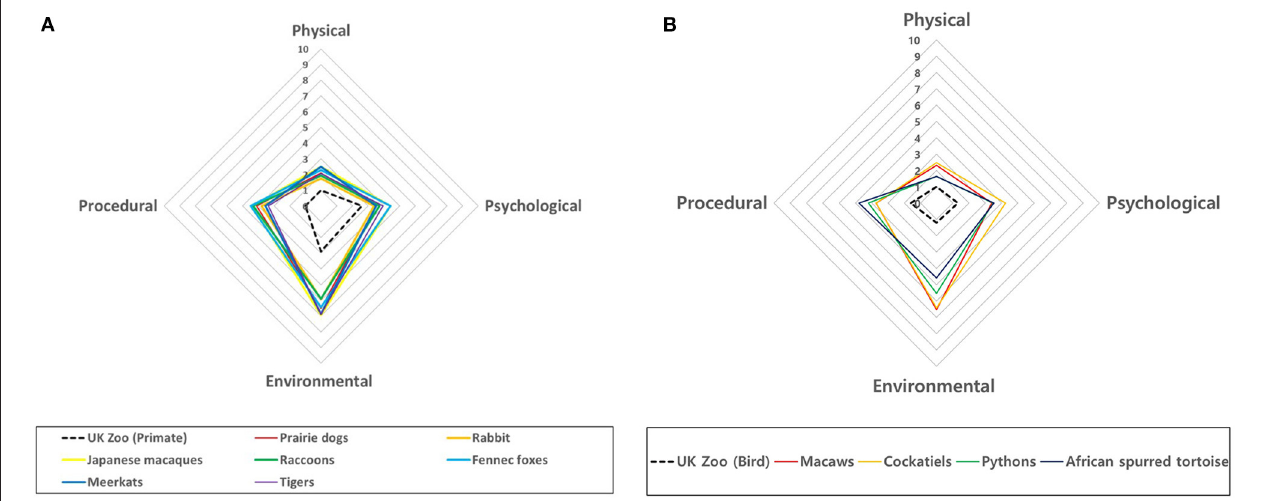
FIGURE 1 | Modified Animal Welfare Assessment Grid for individuals of 11 species in South Korea (solid line) and all primates and all birds in the UK (dotted line). The shapes of the scores for the 11 Korean species were similar and larger than those for the UK primates and birds. (A) Comparison between UK primates and Korean mammals. (B) Comparison between UK birds and Korean birds and reptiles.